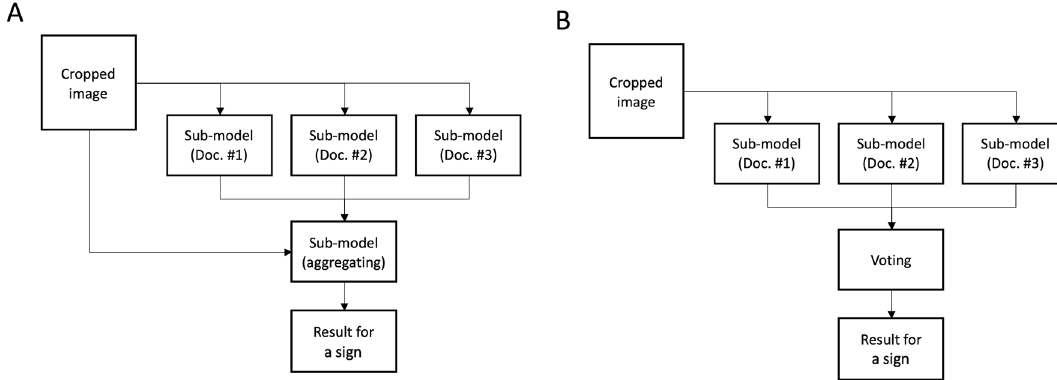
Figure 2. Structural diagram showing the aggregating model ( A ) and voting model ( B